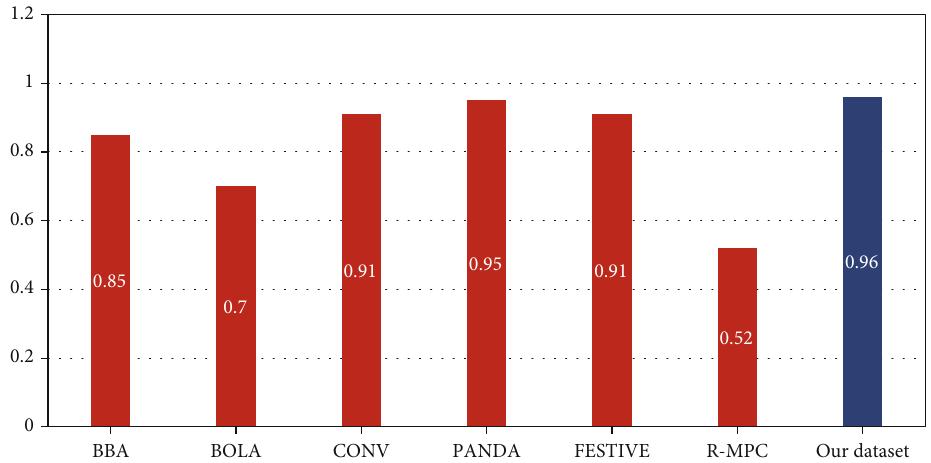
Figure 8: Comparison of the six datasets training results using KNN in the study [29] and our generated dataset training results using KNN. Table 5: Limitations of related work approaches and how the proposed framework addressed it. Related works